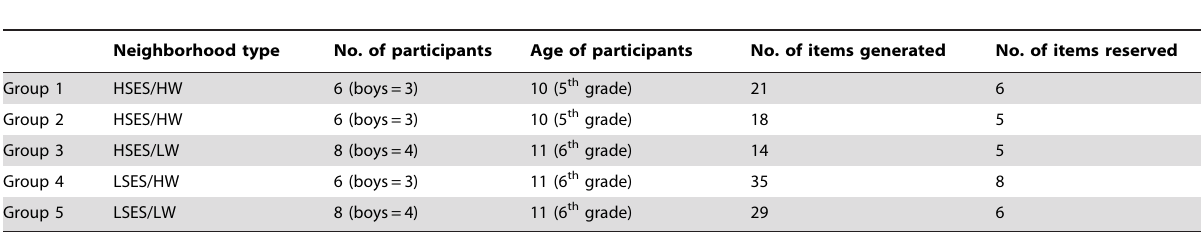
Table 1. Characteristic of NGT